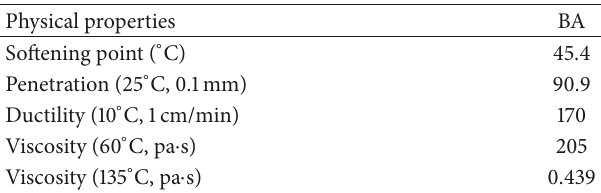
Table 1: Physical properties of BA.